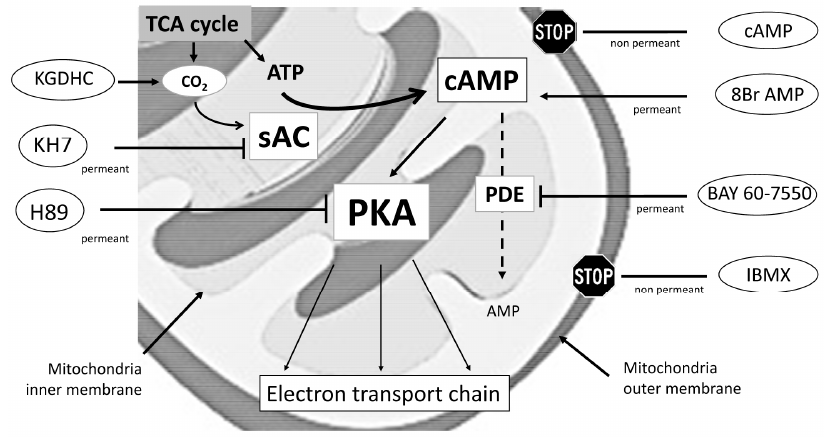
Figure 1. Schematic description of electron transfer chain control by mitochondrial cAMP-PKA signaling. TCA: acid tricarboxylic acid (TCA) cycle or the Krebs cycle; sAC: soluble adenylyl cyclase; PKA: protein kinase A; PDE: phosphodiesterases; cAMP: cyclic adenosine monophosphate. Solid arrow indicates “stimulatory effects”; T-bar indicates “inhibitory effects”; dotted arrow indicates “decomposition”.